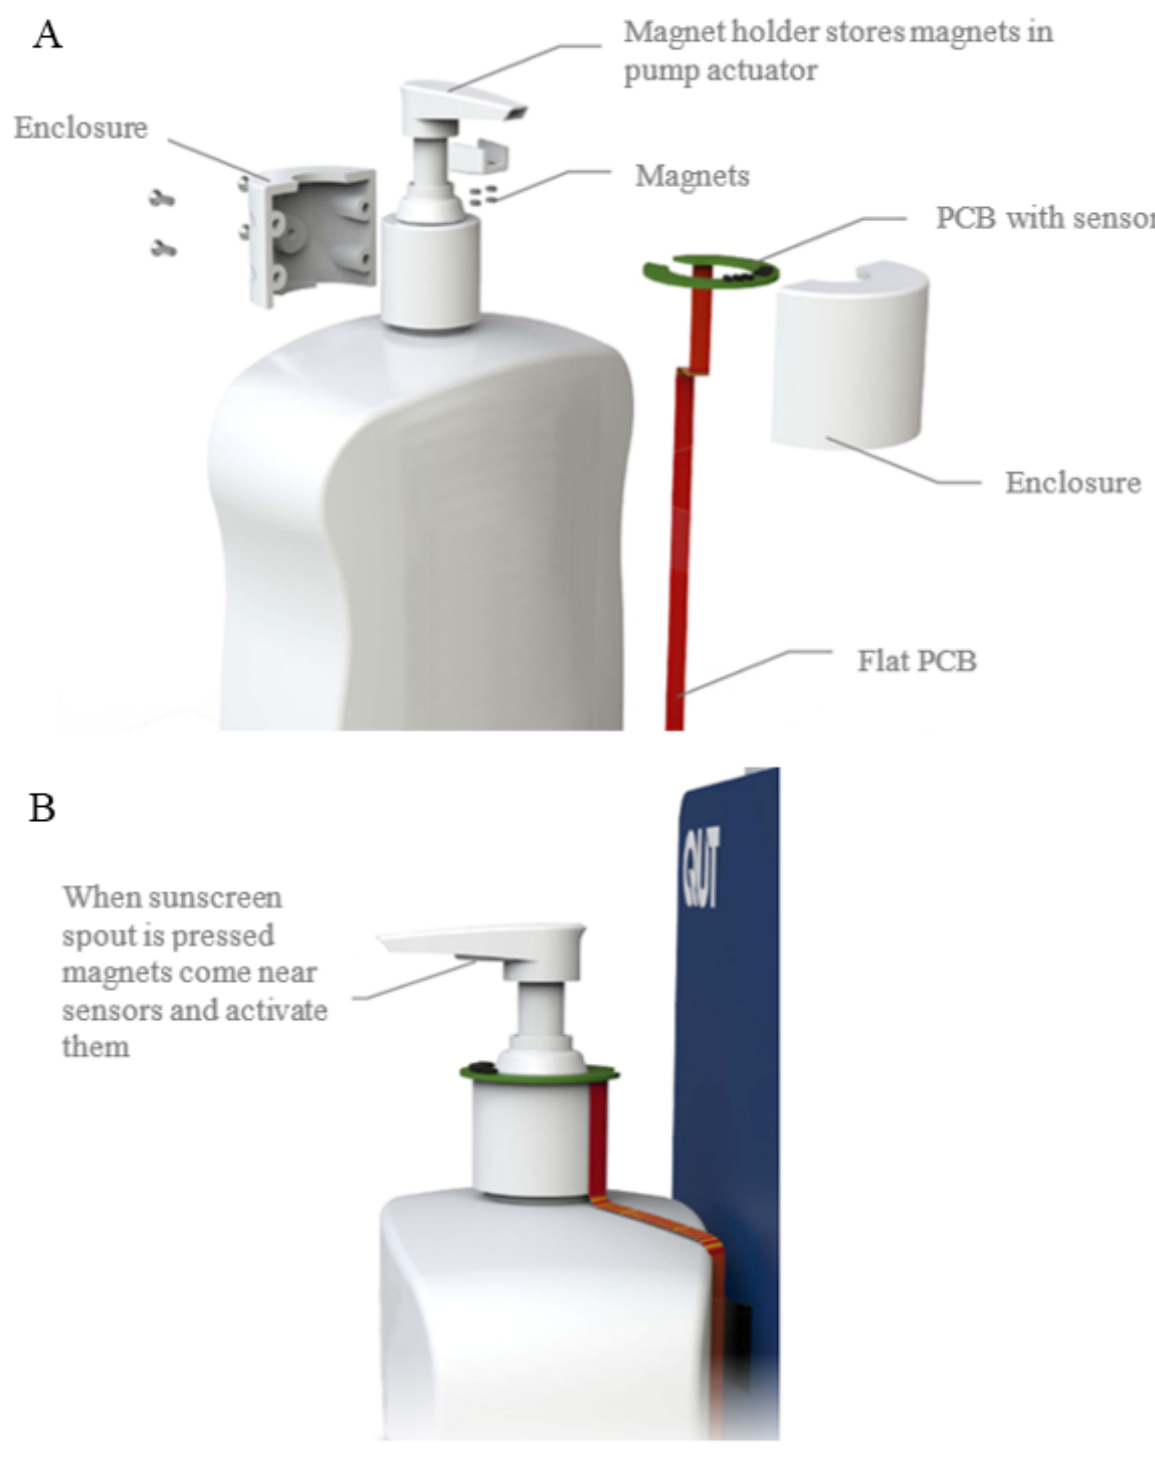
Figure 1. Smart sunscreen station measuring sunscreen dispensing with (A) retrofitted sunscreen sensor assembly and (B) pump mechanism and sensor detection concept. PCB: printed circuit